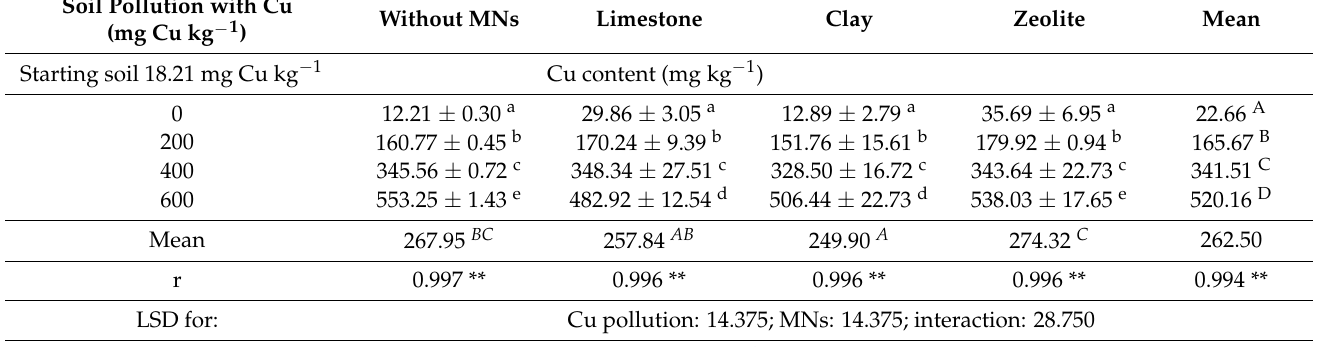
Table 4. Cu, Zn, Cr, and Ni content in the soil after black mustard ( Brassica nigra L. Koch)